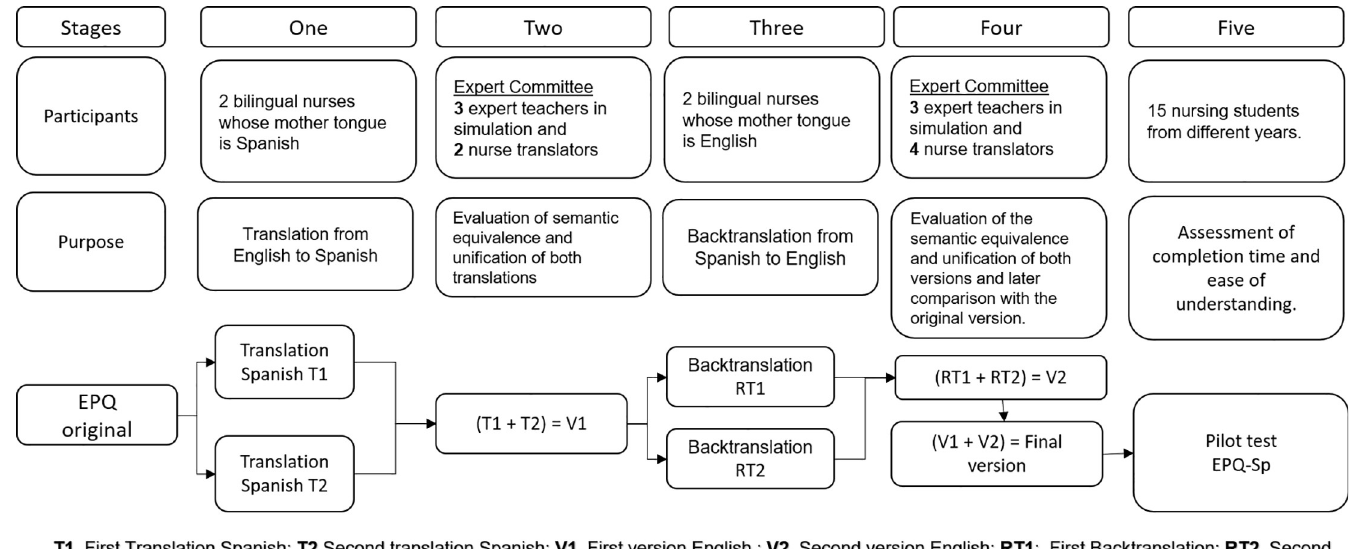
Fig 1. Description of phase: Adaptation to Spanish of the “Educational Practices Questionnaire” (EPQ).